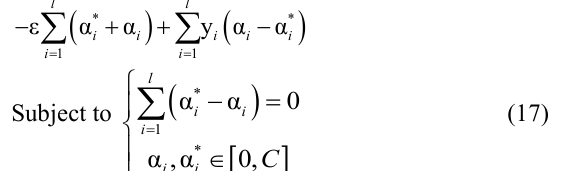
place on every participating processor. Each process only uses values stored in the local memory of the processor. The computations are independent in the sense that they occur asynchronously of all the others.